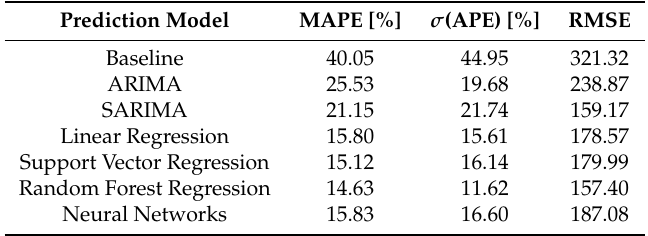
Table 1. Long-term temporal prediction—Mean Absolute Percentage Error (MAPE), Standard Deviation of the Absolute Percentage Error (APE) and Root Mean Square Error (RMSE) for each prediction model in the validation